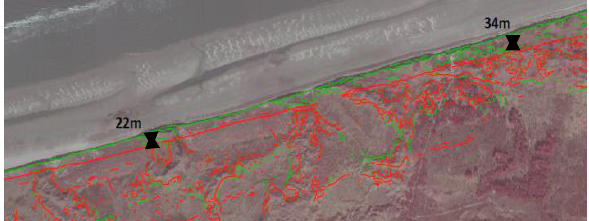
Figure 4. Orthoimage of 2004 and edges derived from the DTM for the dataset of 2004 (green) and 2010 (red) at the northern border